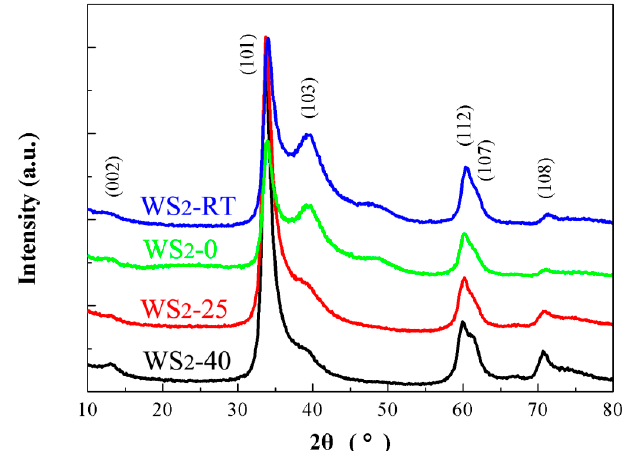
Figure 3. X-ray diffraction (XRD) patterns of the sputtered WS 2 films deposited at different substrate temperature: WS 2 -40; WS 2 -25; WS 2 -0; and WS 2 -RT.